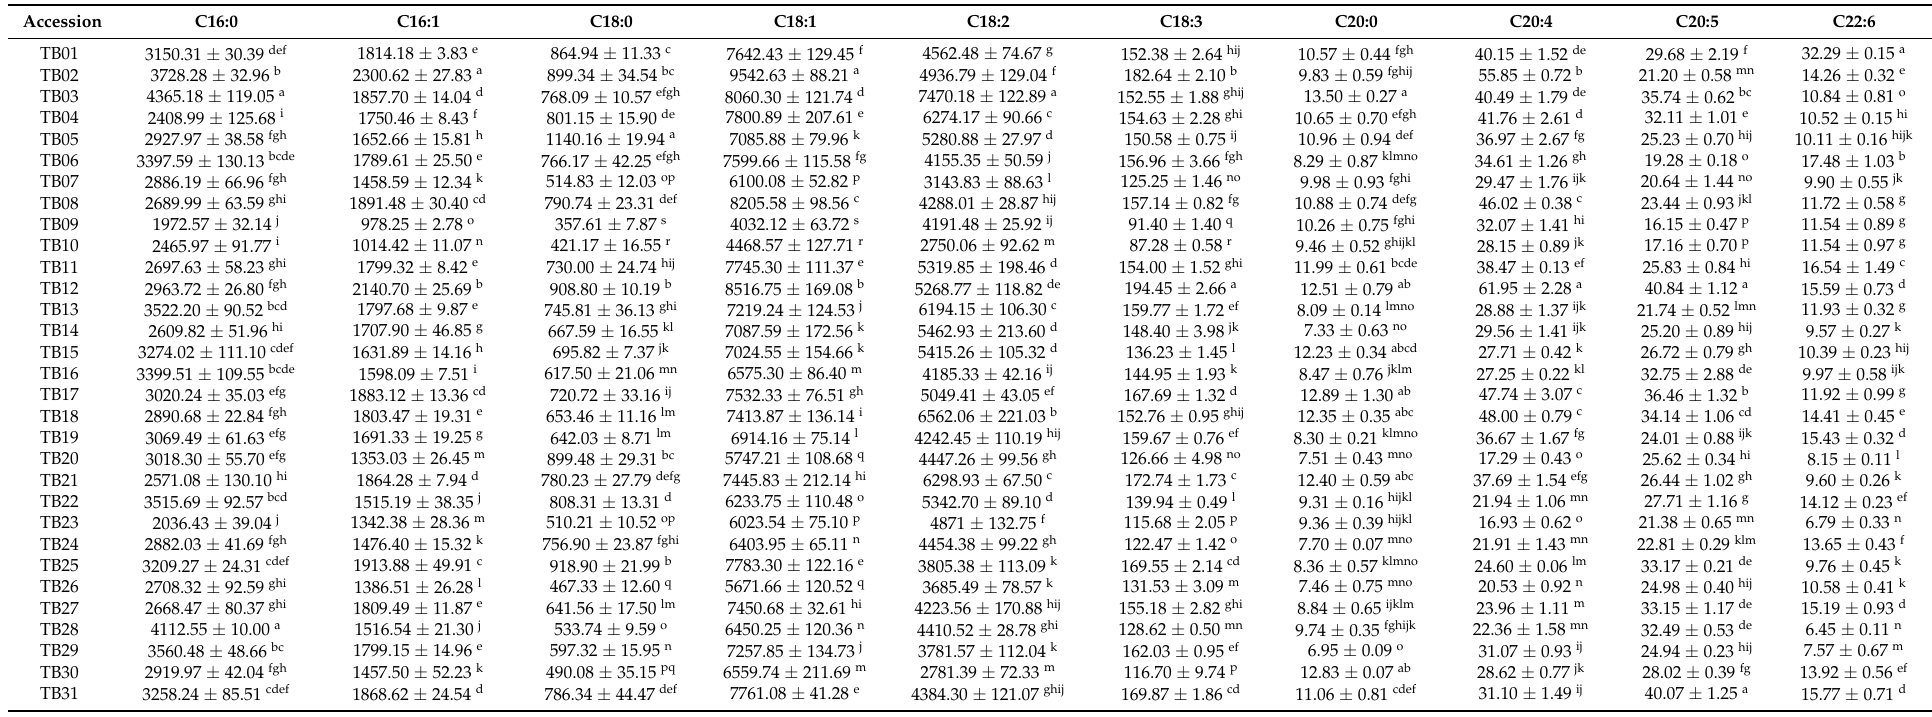
Table 1. Seed fatty acid contents of different Tartary buckwheat accessions ( µ g g − 1 DW, mean ± SD, n = 3). Mean values in the same column with different letters are significantly different, at p < 0.05. C16:0, palmitic acid; C16:1, palmitoleic acid; C18:0, stearic acid; C18:1, oleic acid; C18:2, linoleic acid; C18:3, linolenic acid; C20:0, arachidic acid; C20:4, arachidonic acid; C20:5, eicosapentaenoic acid; C22:6, docosahexaenoic